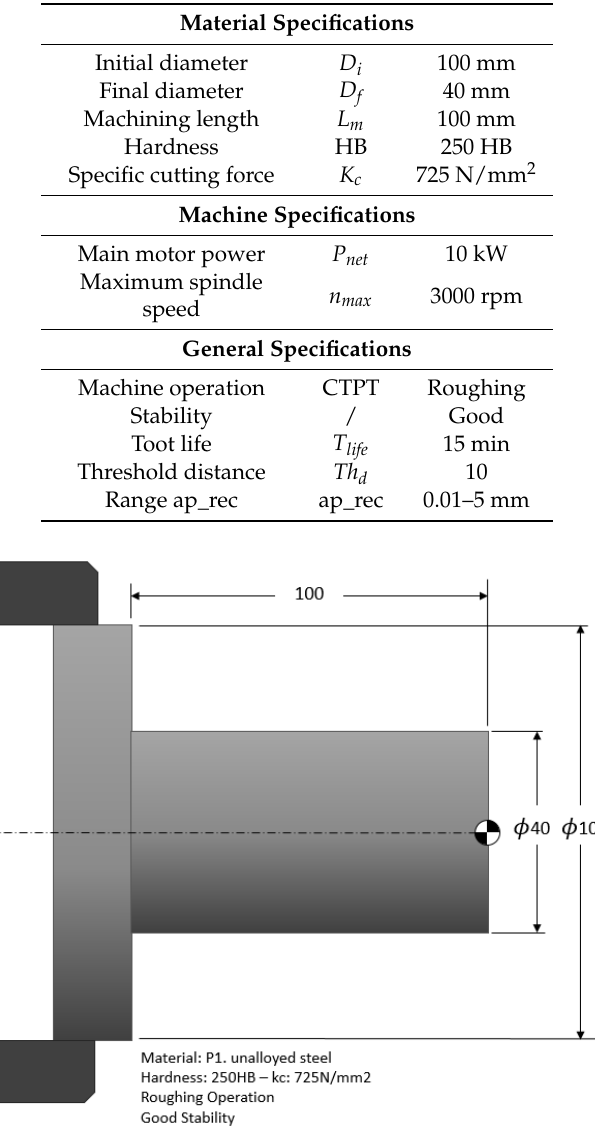
Figure 13. Example of heavy roughing operation.